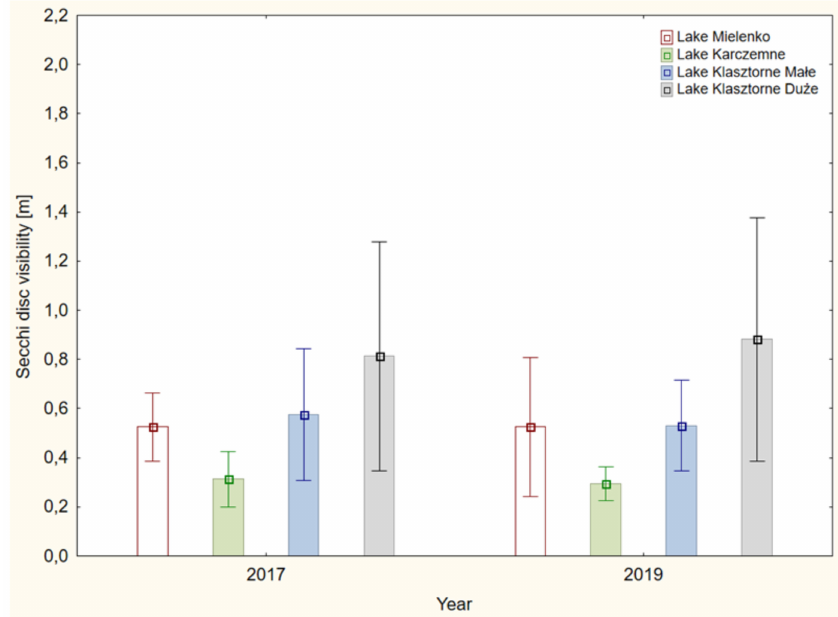
Figure 8. Mean annual values of transparency of Kartuzy lake complex in selected research years. (box ± SEM, whisker plots ± Standard